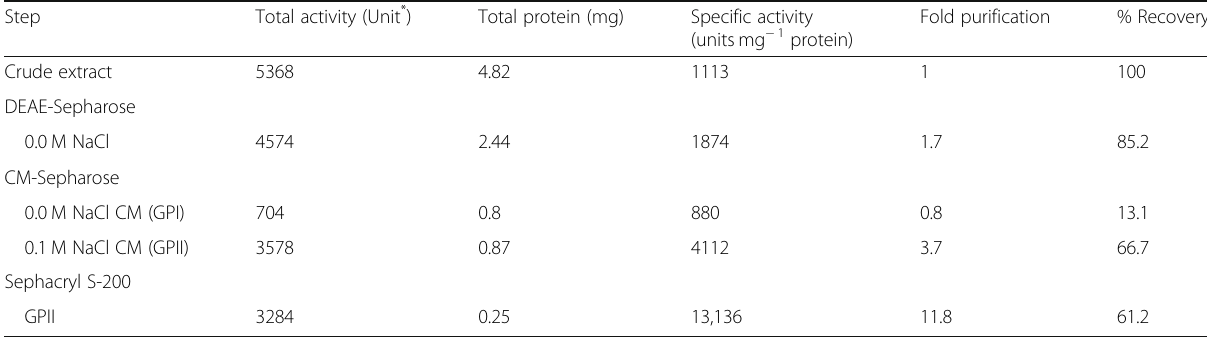
Table 1 Purification scheme of peroxidase from ginger Step